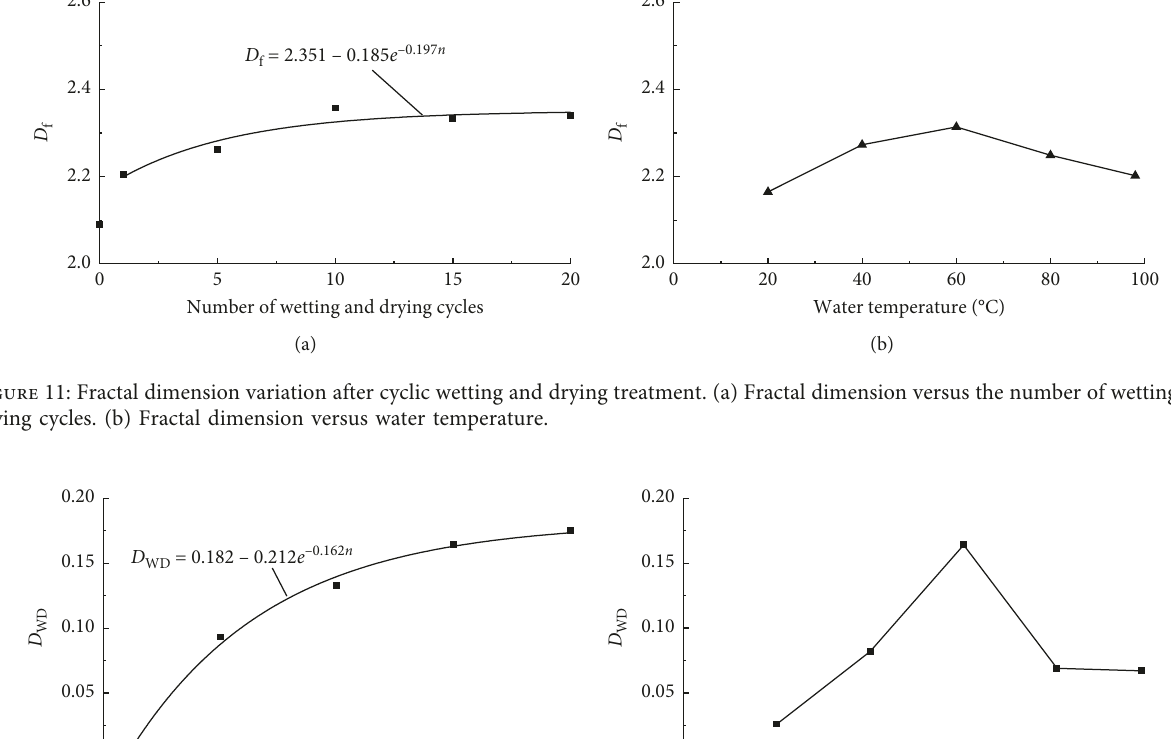
D = 0.182 – 0.212 e –0.162 n WD